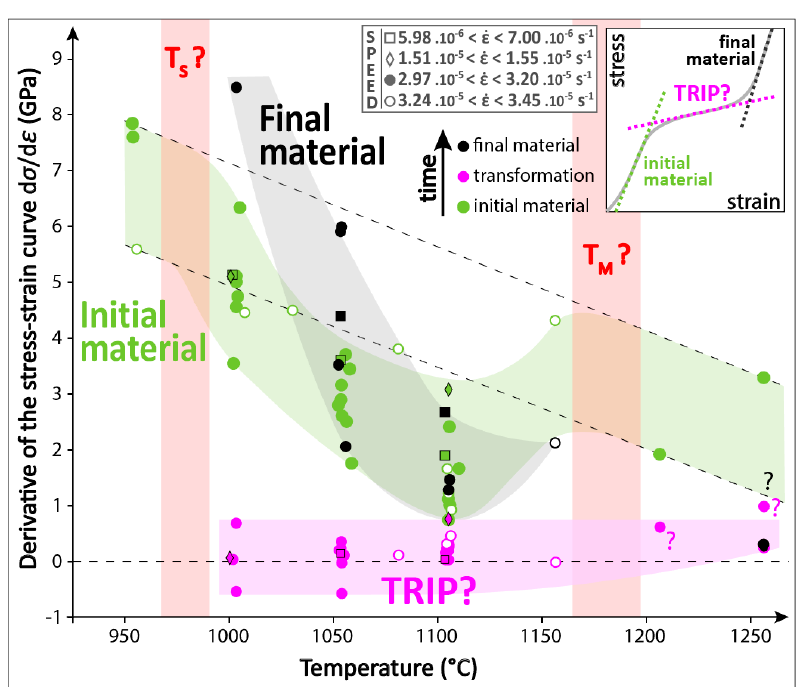
Figure 6. Set of experiments for a loading rate of 0.2 µm·s –1 up to 1038 N. ( a ) Stress as a function of axial strain during the loading step (grey shade) and the creep test (red shade), for temperatures between 1005 and 1207 °C; ( b ) Strain as a func- tion of time at a constant load of 1038 N. Vertical arrows on ( a ) account for the load target, i.e., beginning of the “creep test” ( b ).